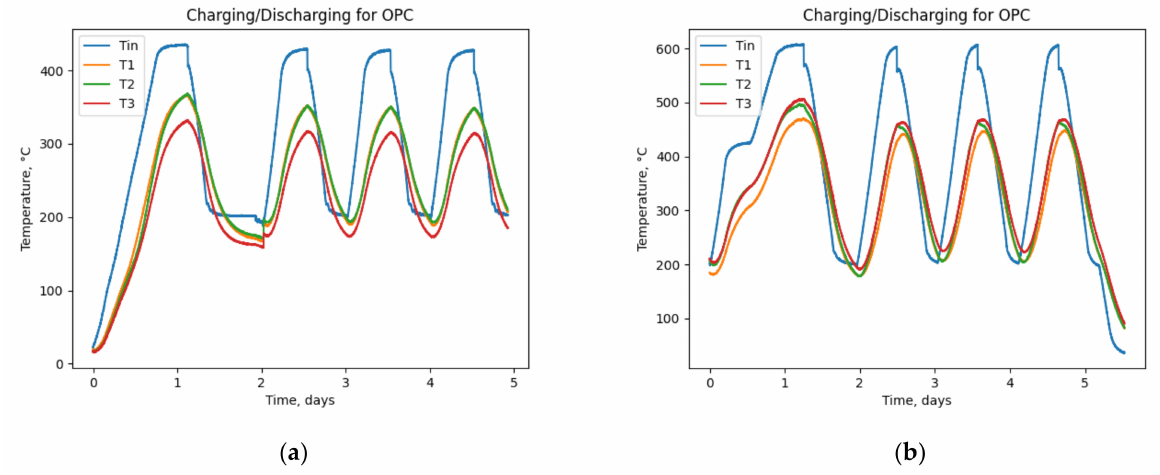
Figure 5. OPC concrete. ( a ) Low-temperature cycles (the temperature of the inlet varying from 200 ± 25 ◦ C to 400 ± 25 ◦ C); ( b ) high-temperature cycles (the temperature of the inlet varying from 200 ± 25 ◦ C to 600 ± 25 ◦ C). T1,T2, and T3 are thermocouples shown in Figure 1. Tin is the HTF (air) inlet temperature.